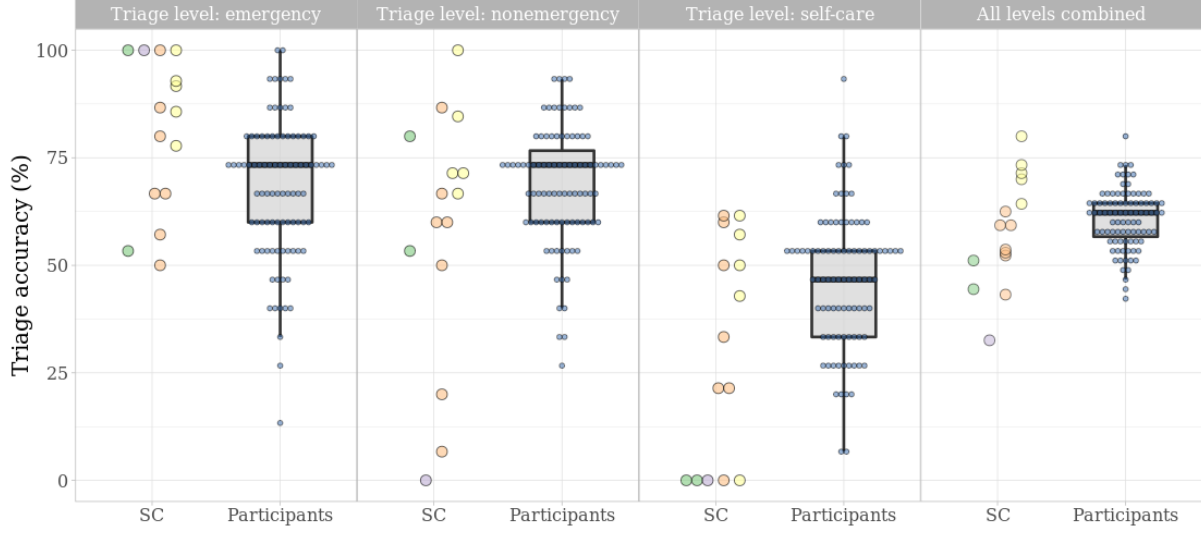
Figure 3. Accuracy of SCs and participants by triage level (Em), nonemergency, and S-c. The accuracy of individual participants is indicated with blue dots. The aggregate accuracies of participants are shown as box plots. Em: emergency; SC: symptom checker; S-c: